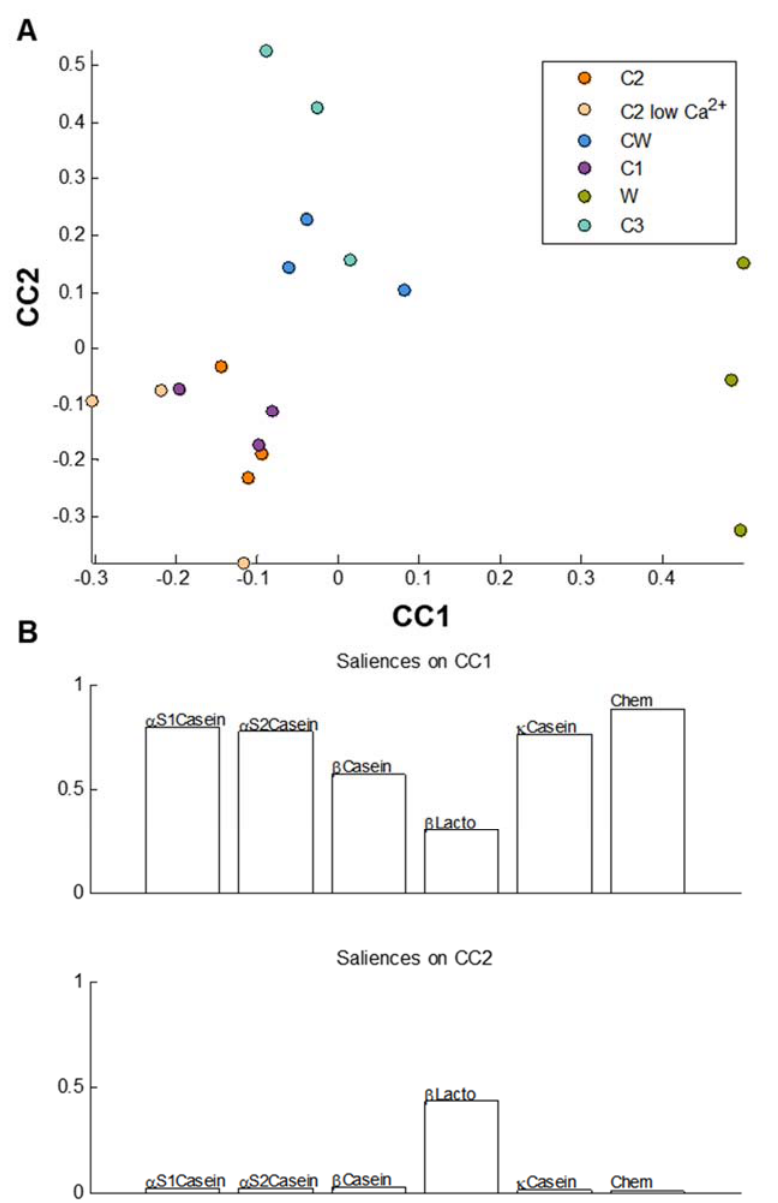
Figure 6. Common component and specific weight analysis (CCSWA) of the different matrices at the end of the gastric phase for all three replicates of the matrices: ( A ) CC1 vs. CC2 score plot and ( B ) saliences on CC1 and CC2.